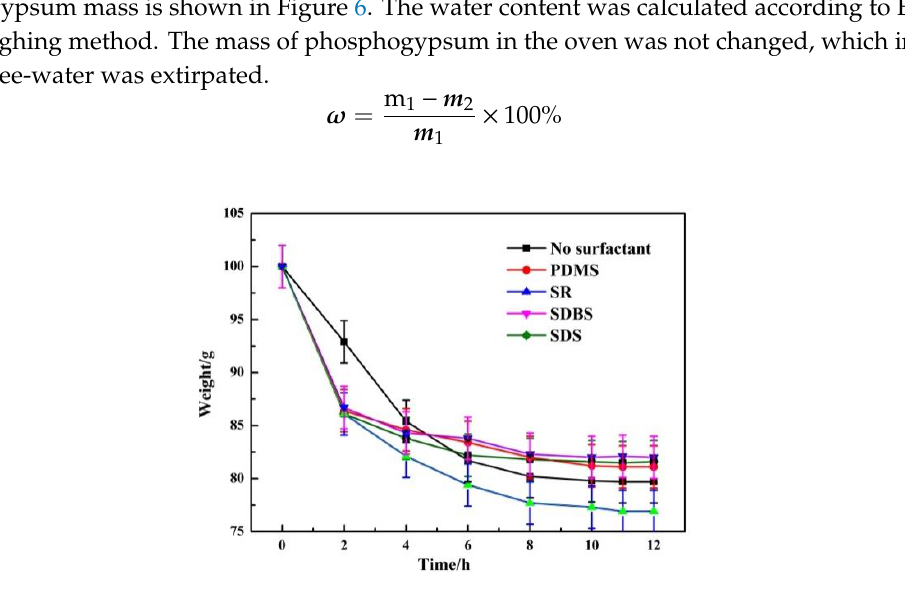
Table 7. Rate of water content of phosphogypsum after the modification of the compound surfactants.